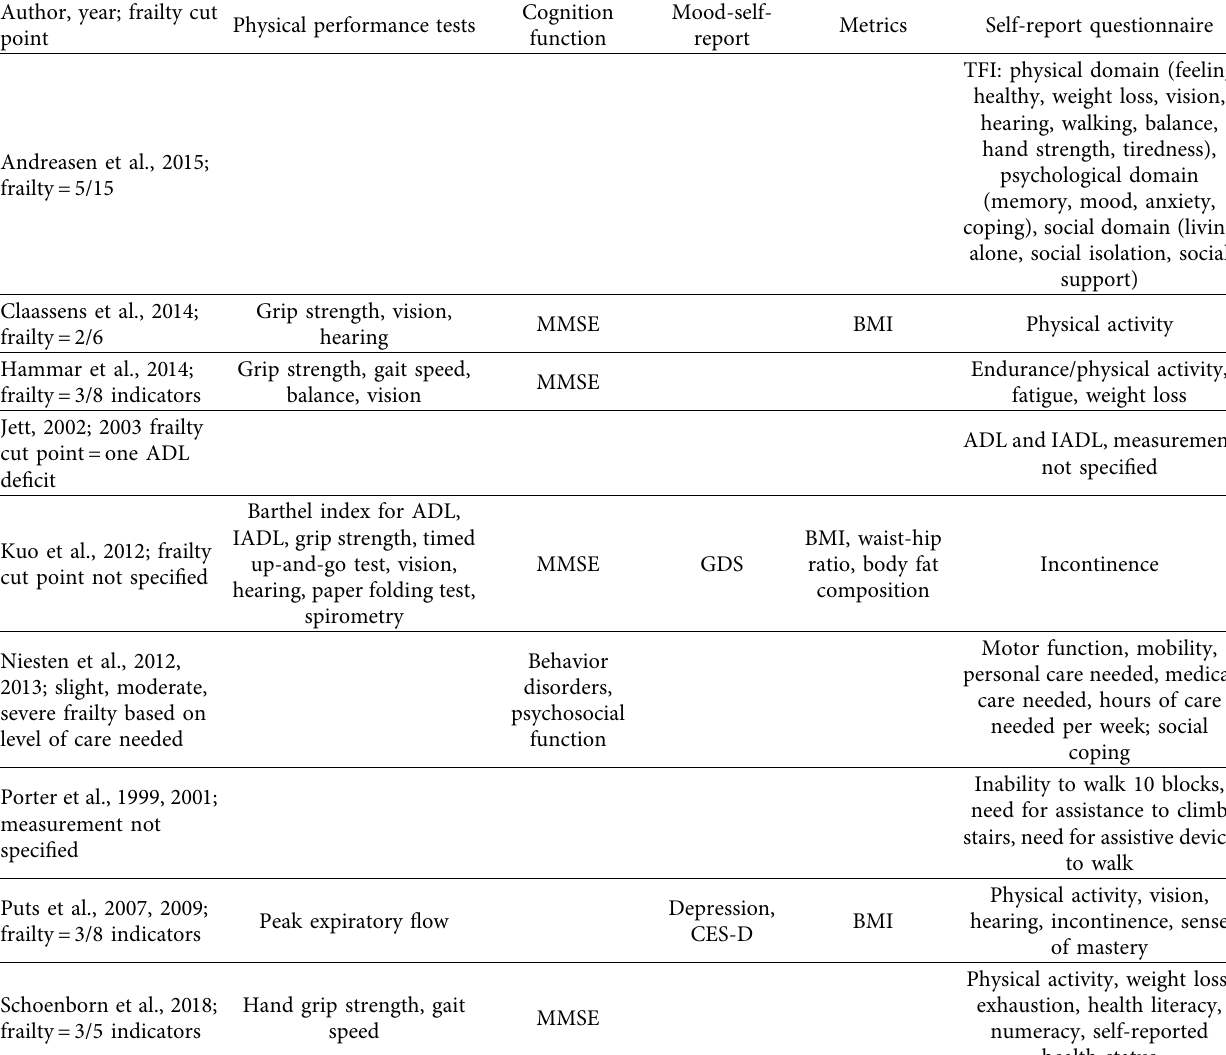
Table 3: Quantitative measurement of frailty in qualitative research studies ( N �